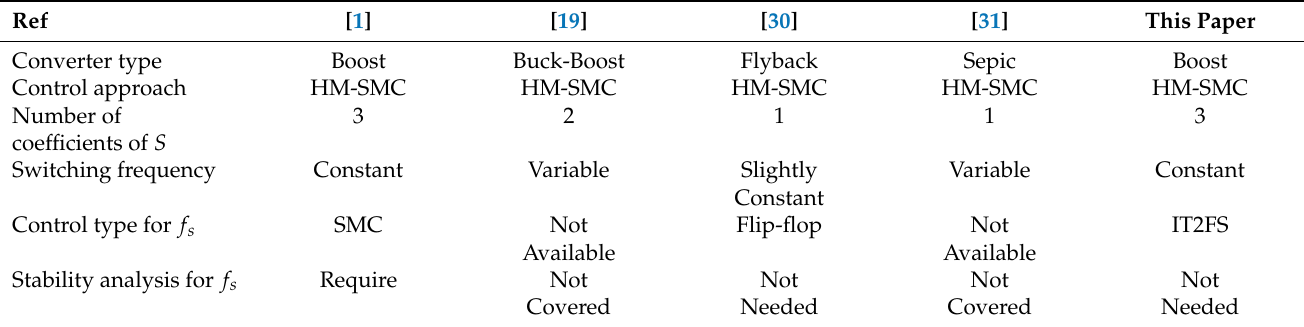
Table 3. Comparison of HM-SMC studies with proposed control methods from different